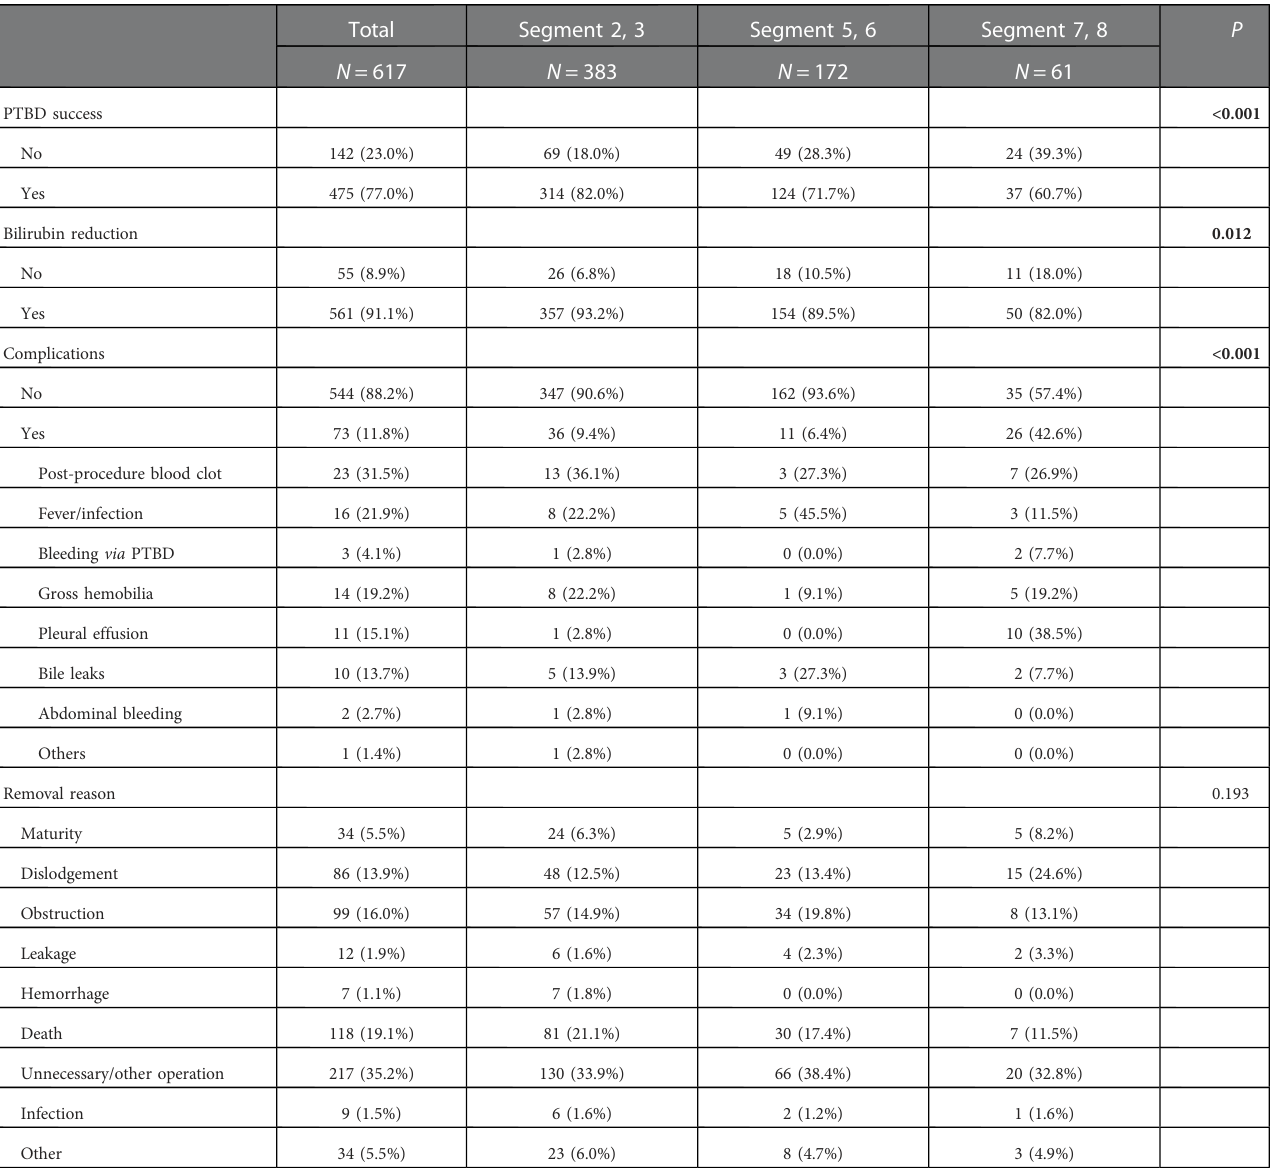
TABLE 2 Clinical outcomes of PTBD success, bilirubin reduction, and